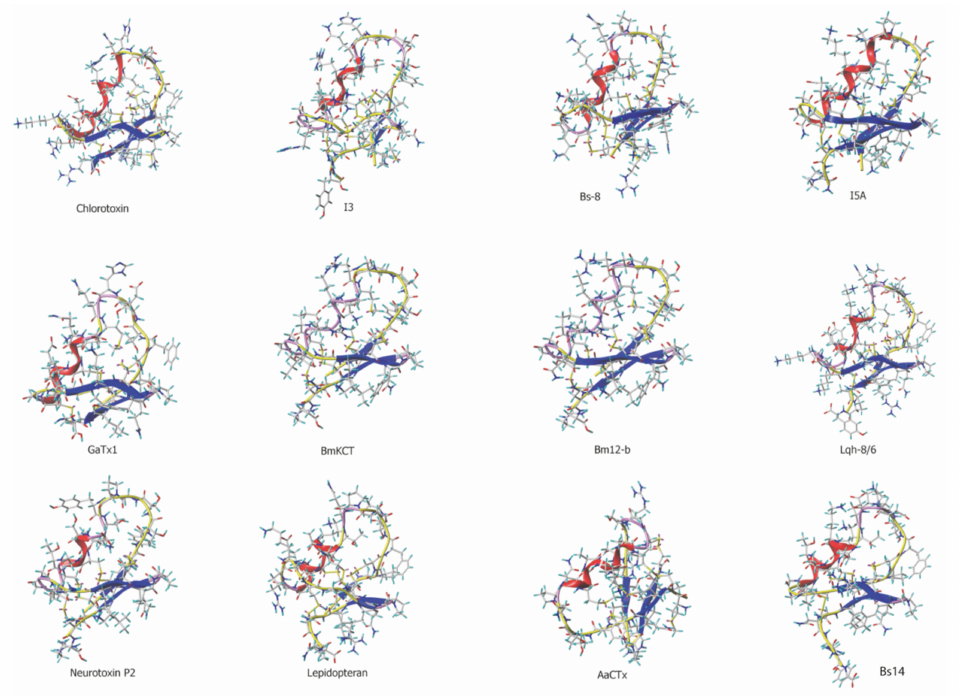
Figure 1. Three-dimensional structure of chlorotoxin and chlorotoxin-like peptides. The 3D structure of chlorotoxin and I5A were obtained from their pdb files: 1CHL (chlorotoxin) and 1SIS (I5A). All other structures are models built by homology with chlorotoxin using @TOME V2 and modeler for Lqh-8/6, Bs-8, Bs-14, I3, GaTx1, BmKCT, Bm12-b, neurotoxin P2, AaCTx and lepidopteran. All toxins present an anti-parallel β -sheet structure and most an alpha helix (with the exception of BmKCT and